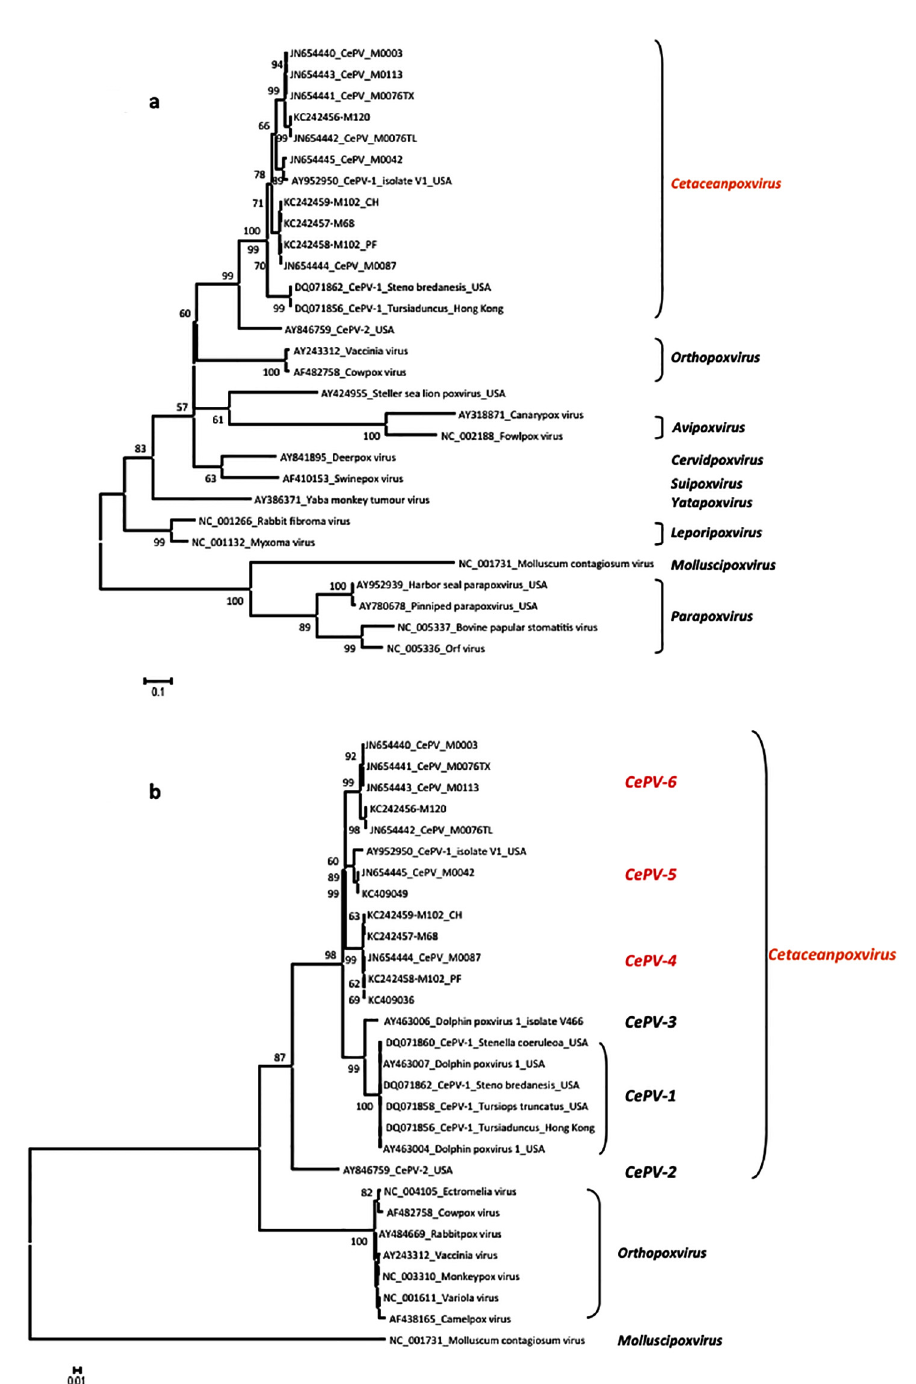
Fig 4. Phylogenetic analysis of the polymerase gene of cetacean poxviruses and reference sequences available from GenBank representing the known genera in the sub-family Chordopoxvirinae. The phylogenetic tree was constructed by MEGA 5 software and the confidence levels were calculated using bootstrapping (2000 replicates). Only bootstrap values greater than 50 are shown. As seen in the overview (Fig 4a), cetacean poxviruses do not cluster with any other known genus, substantiating the notion that they are to be regarded as a separate one. While parts of the overall topology obtain a relatively low statistical support (after extensive bootstrapping) it resembles the established classification